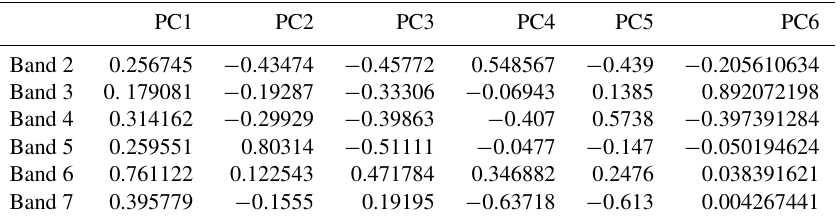
Table 4. Relative contribution of each band to each extracted PC.